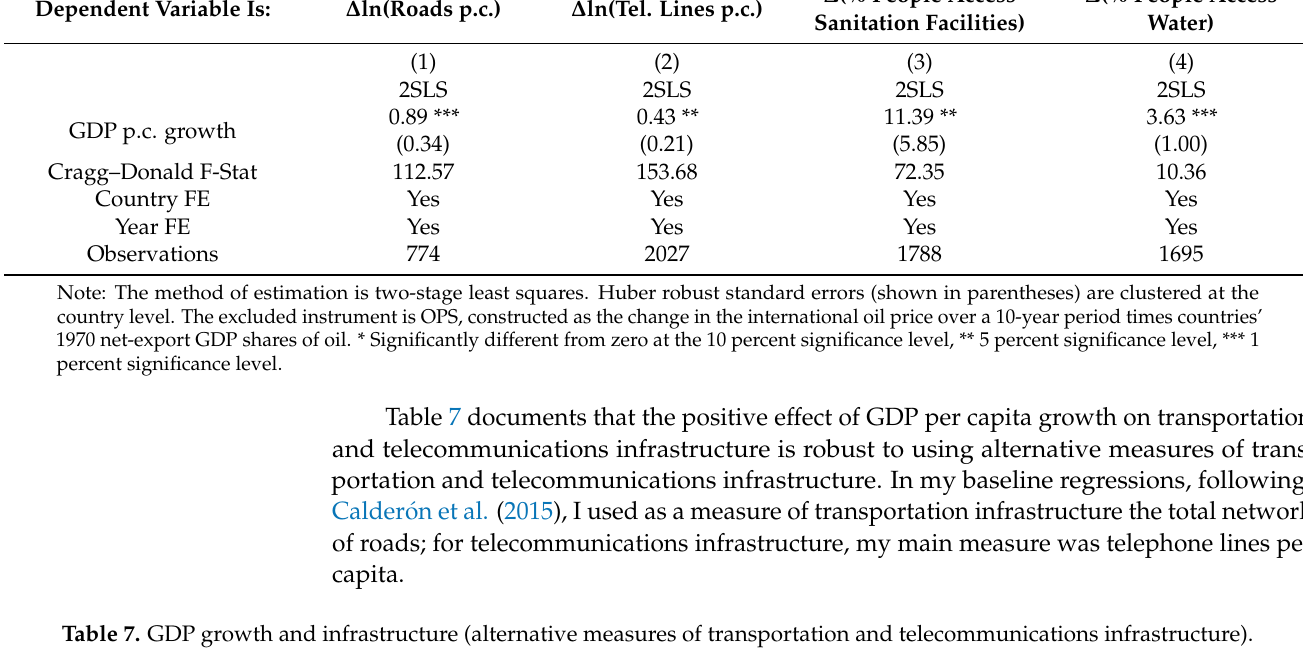
Table 7. GDP growth and infrastructure (alternative measures of transportation and telecommunications infrastructure). Dependent Variable Is: